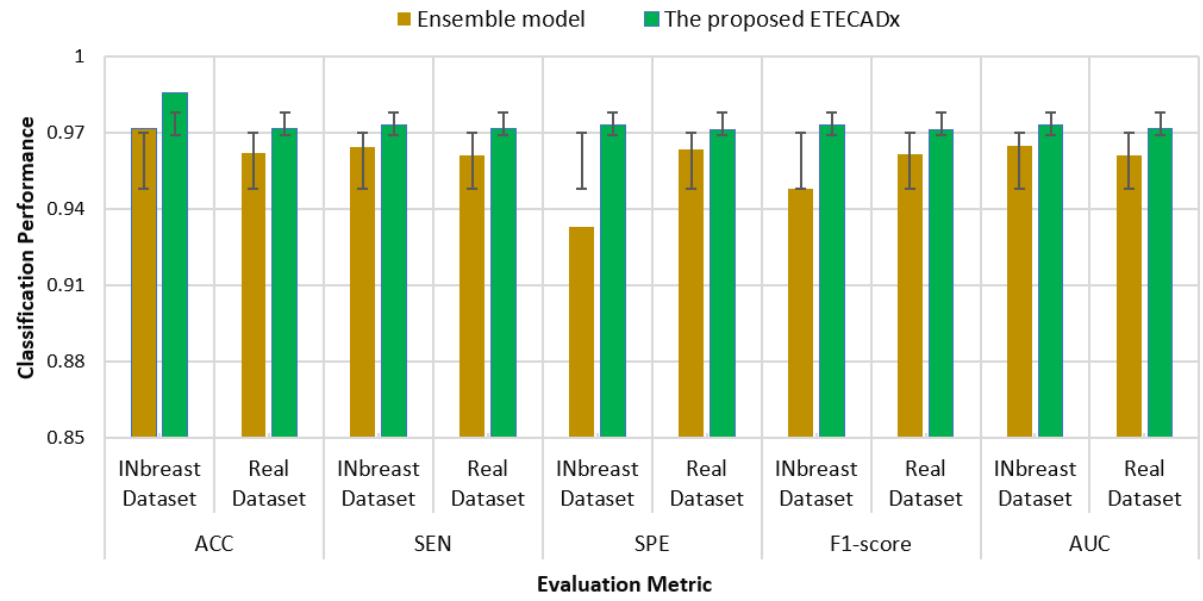
Figure 14. Comparison results of the binary approach for the ETECADx model against the ensemble learning model in both INbreast and real datasets.